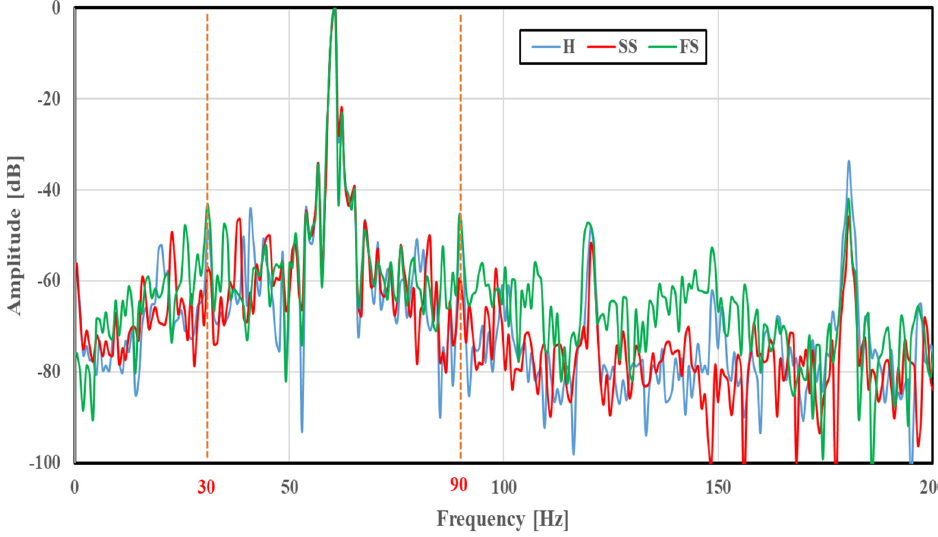
Figure 4. Spectral analysis of H, SS, and FS at 1765 min − 1 .